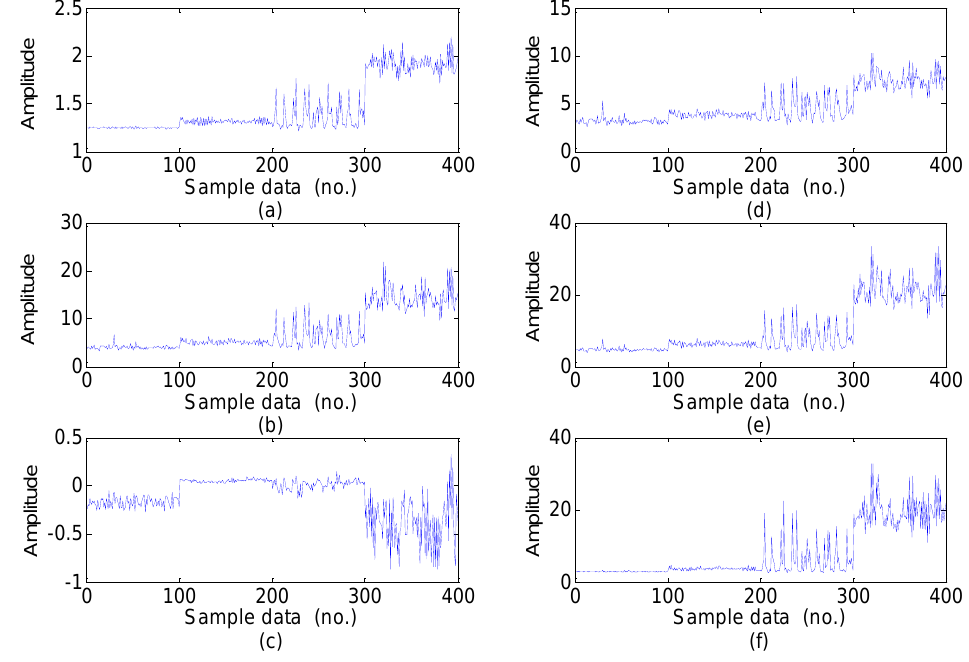
Figure 6. The six dimensionless time-domain features value in the dataset: ( a ) Shape factor. ( b ) Crest factor; ( c ) Impulse factor; ( d ) Clearance factor; ( e ) Skewness factor; ( f ) Kurtosis factor (Note: sample data No.1–100, 101–200, 201–300, 301–400 represent normal, inner race fault, ball fault and outer race faults,